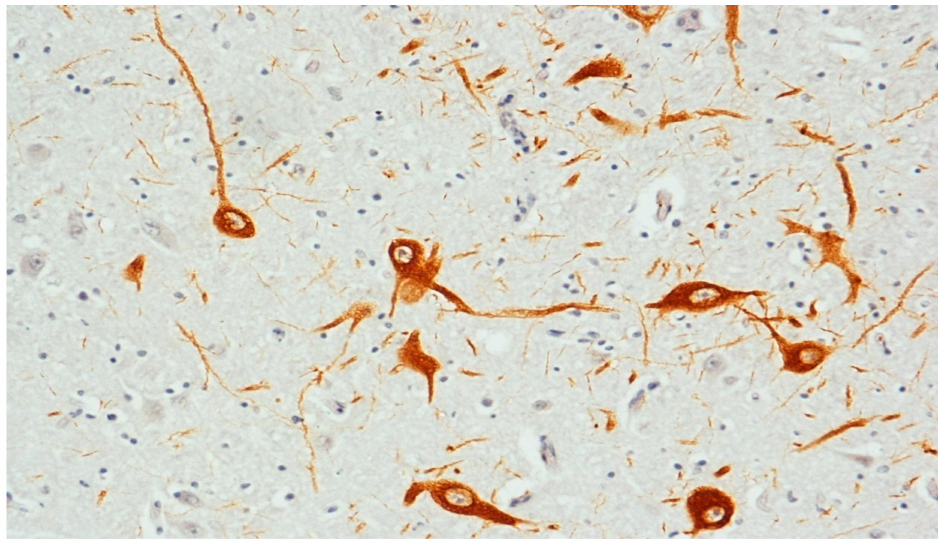
Figure 3. Tyrosine hydroxylase (TH) immunocytochemistry in a SIDS case graded as mild, due to the presence of few dopamine-stained neurons. Original magnification, 20 × .